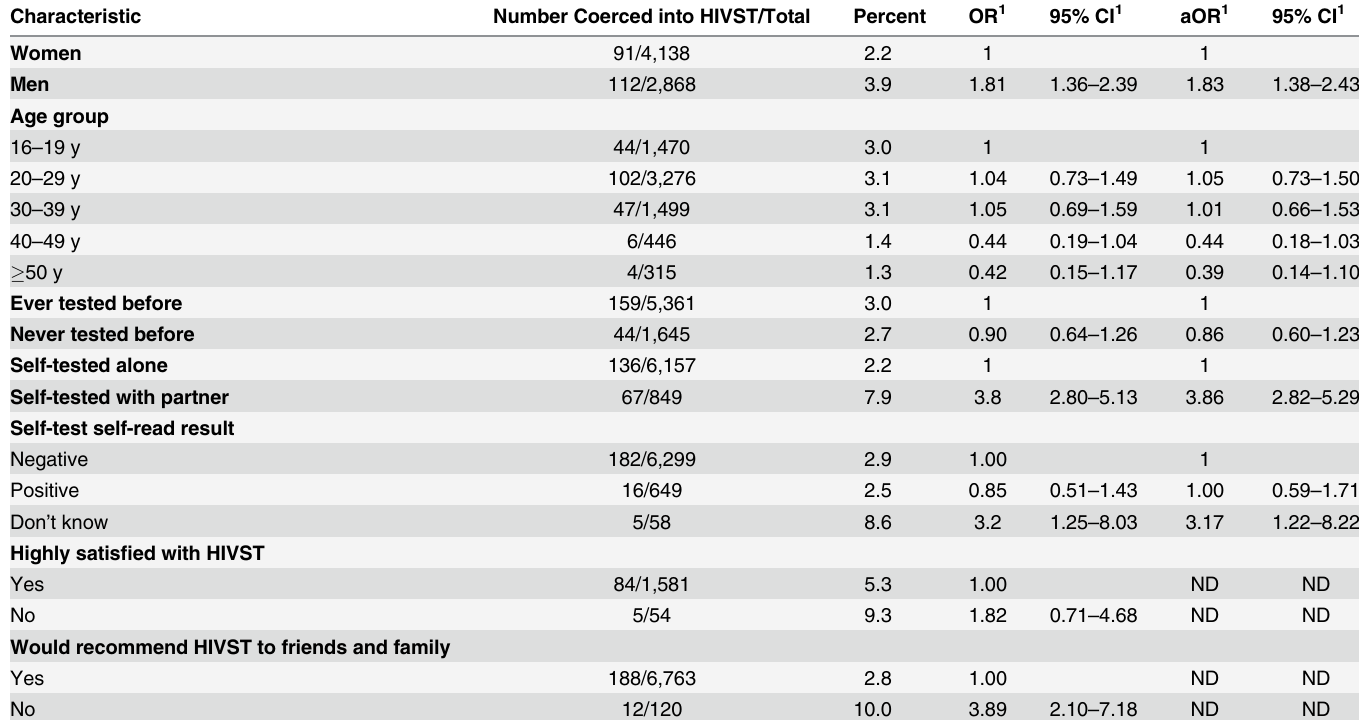
Table 4. Factors associated with reported coercion during months 1 – 12 of HIV self-testing ( n = 7,014).